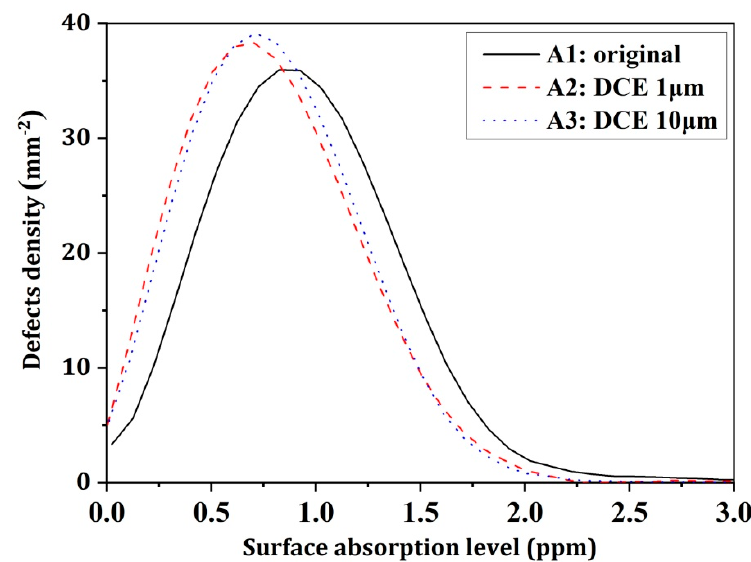
Figure 4. Weak absorption distribution curves of post-treated surfaces.